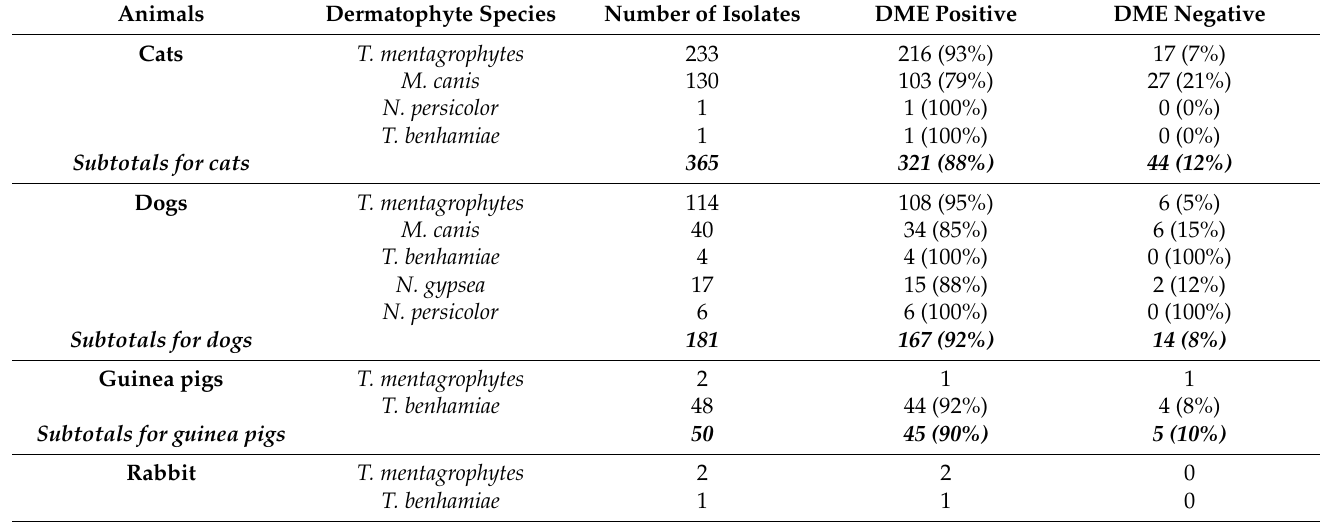
Table 3. Direct mycological examinations per animal for each dermatophyte species isolated in